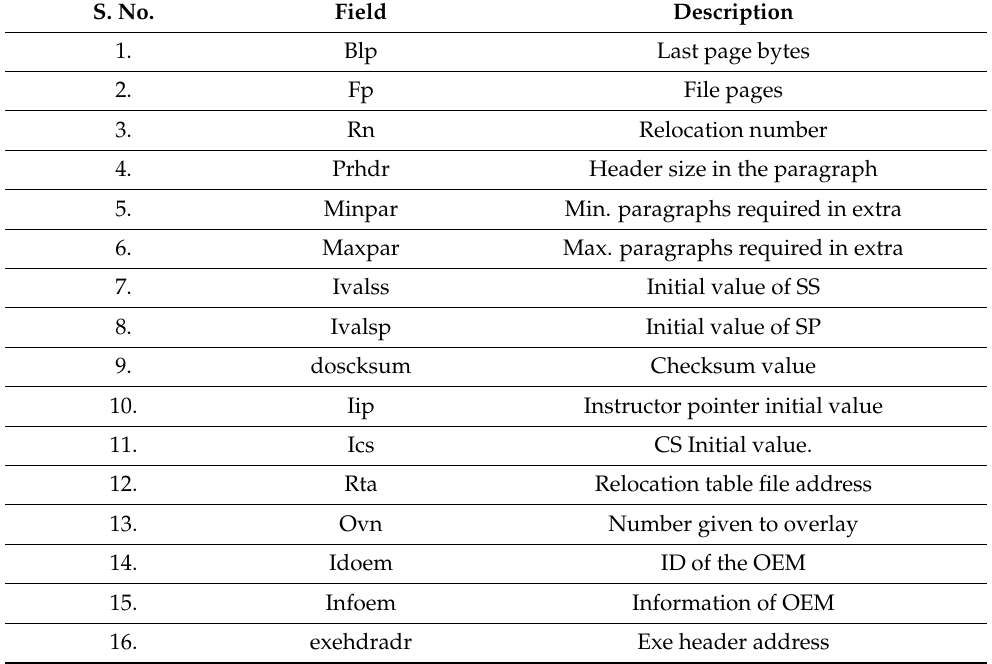
Table 1. DOS_header attributes of